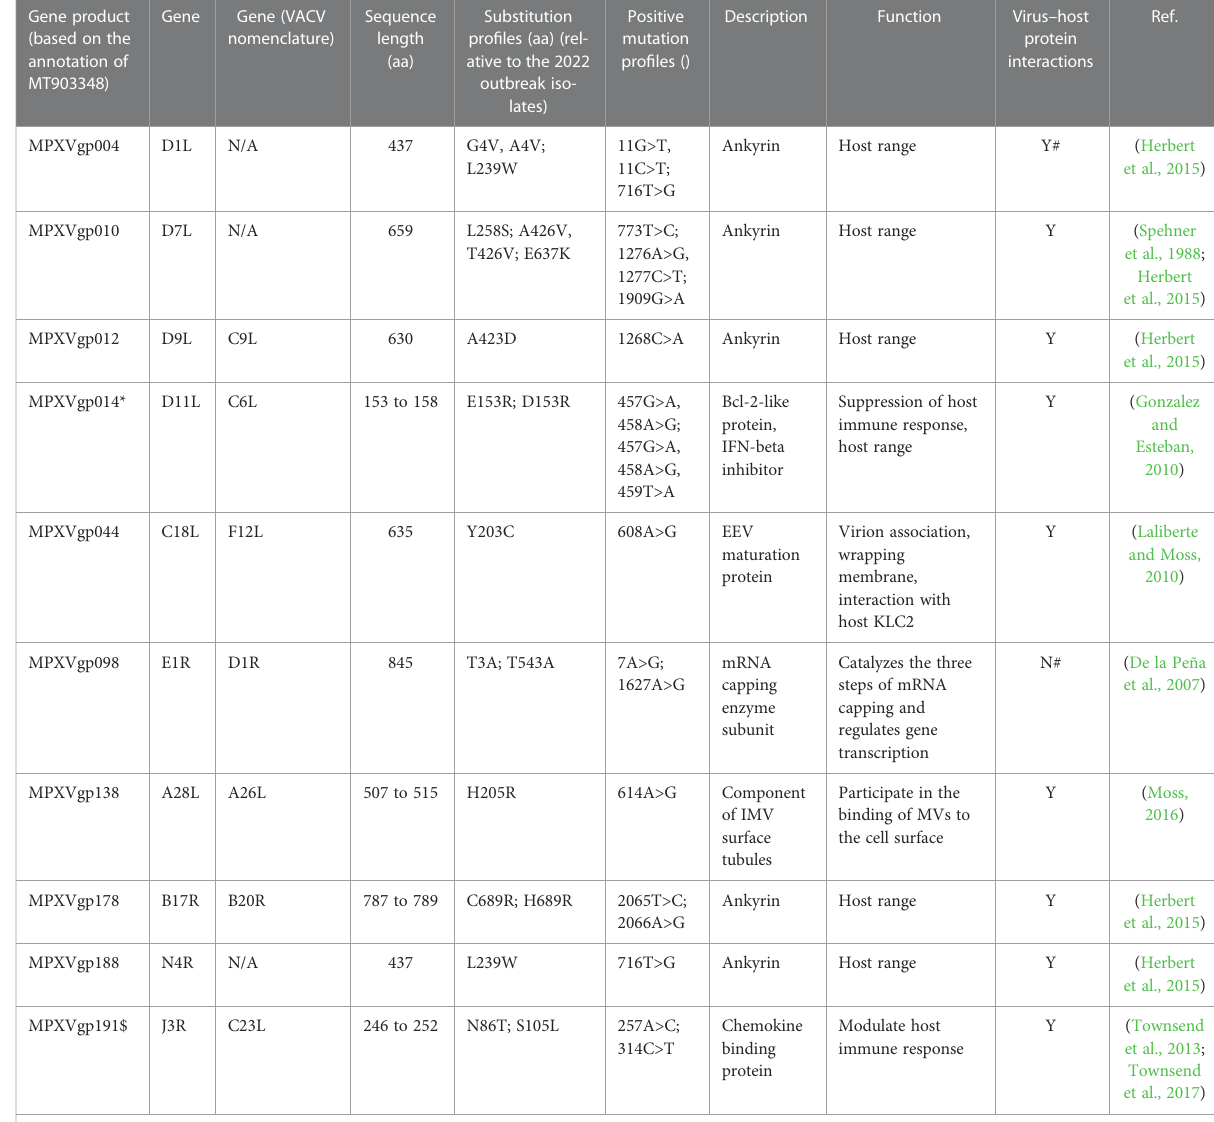
TABLE 4 Description of genes under positive selection at the codon level. Gene product (based on